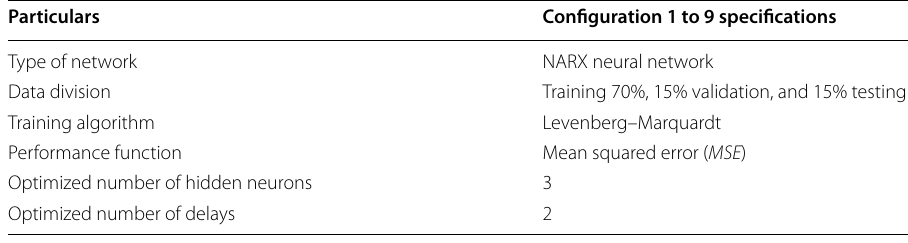
Table 1 NARX model specifications